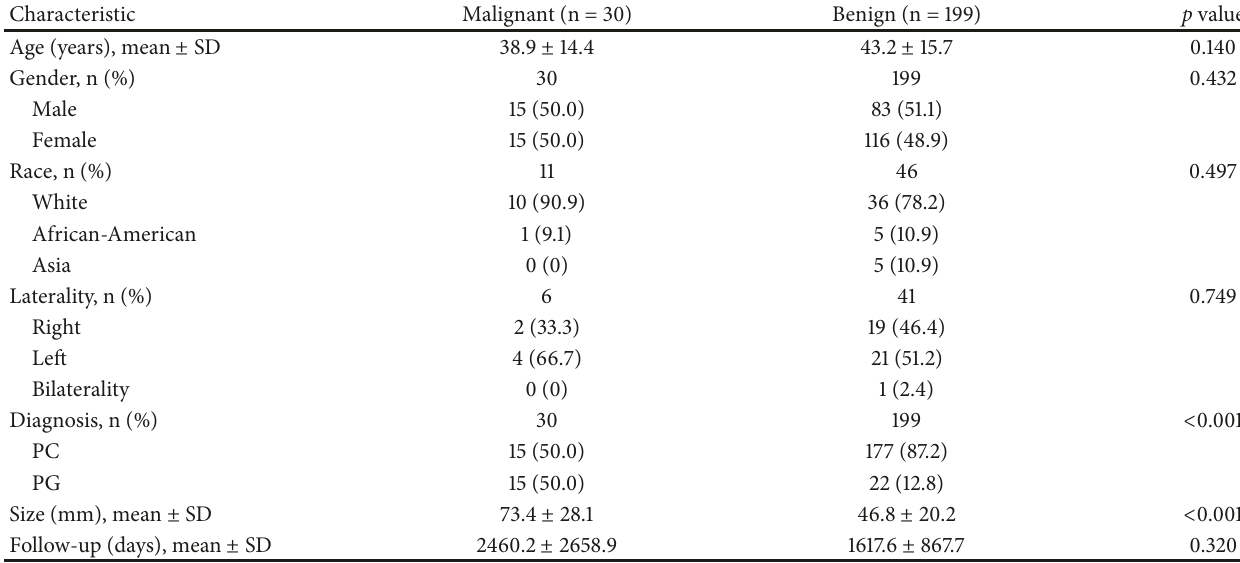
Table 1: Clinical demographics of malignant and benign PC/PG cases obtained from the TCGA database and the COMETE cohort.